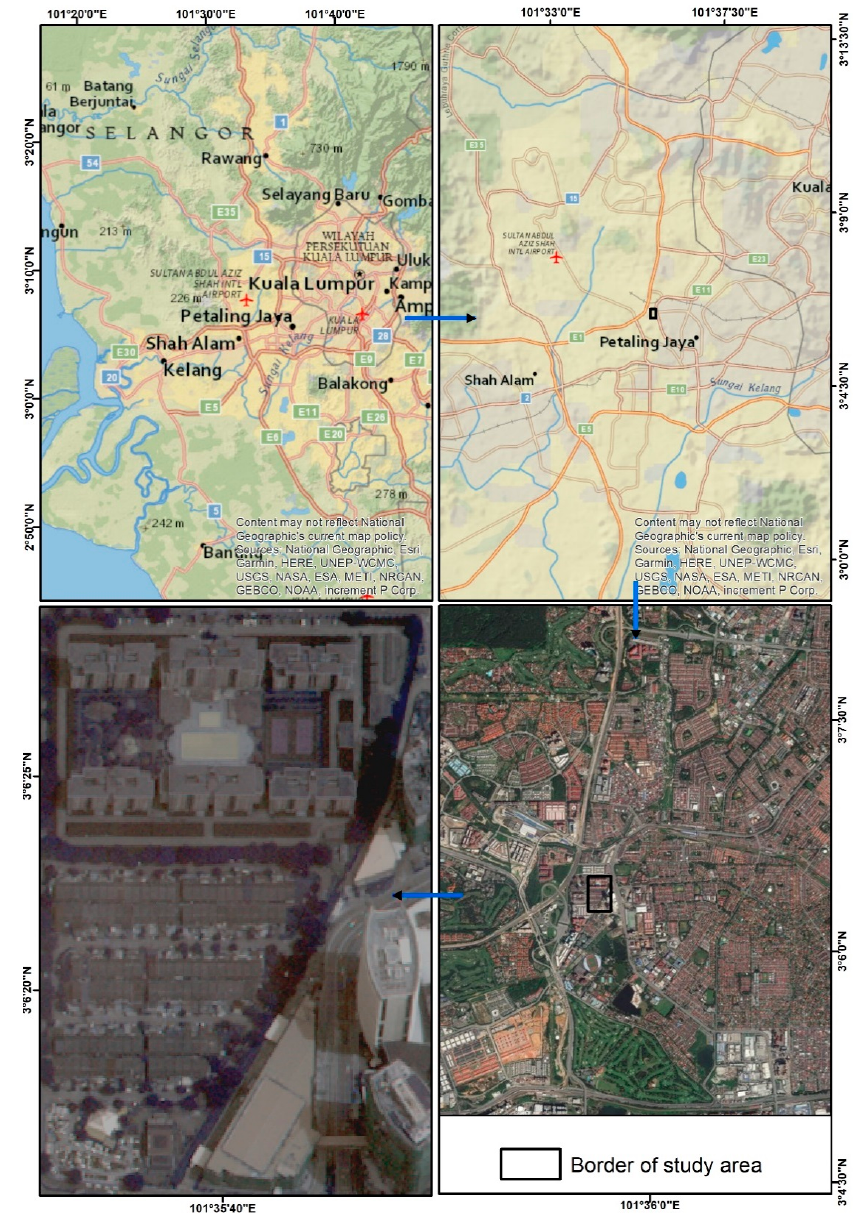
Figure 1. The geographical location of this study. Table 1. Spectral information of WV-3 image.